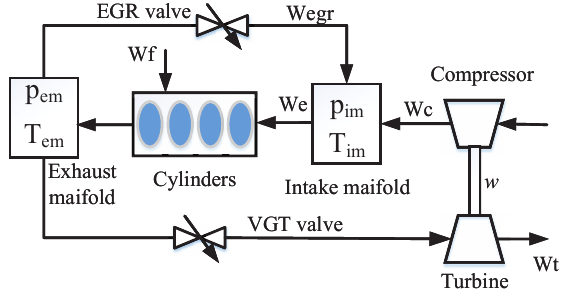
Figure 1. A model structure of the diesel